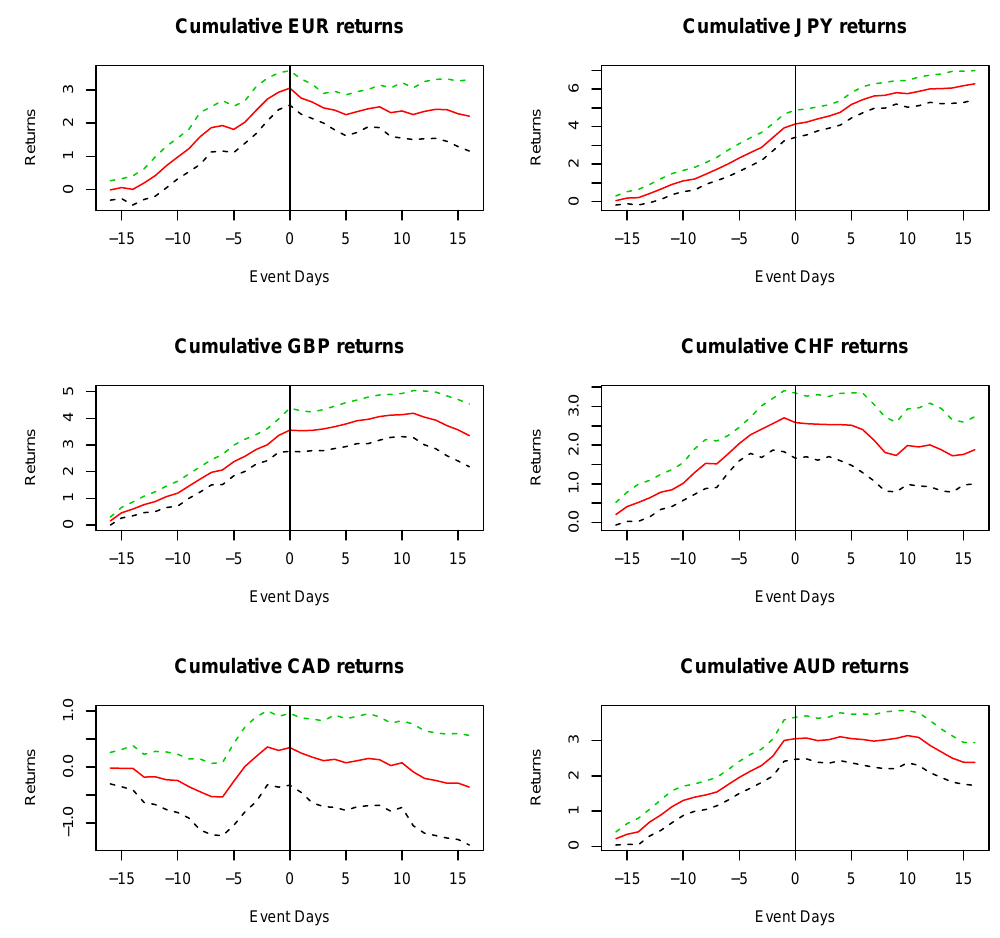
Figure 1. Event Study: Extreme (High 99th percentile) Risk Reversal Skew and 16 day event window: Risk reversals are the ratio of implied volatility on calls to the equivalent put; extreme high is at or above the 99th percentile for the whole range, cumulative returns are the sum of log exchange rate returns. The event day is the day of the extreme risk reversal reading. If speculation is uninformed, extremes should be followed by reversals; if speculation is informed, extremes are more likely to be followed by a random walk. The solid line is the cumulative mean return from the start of the event window; the dashed lines show the 95% confidence intervals constructed from 1000 random bootstrap samples of appropriate event window